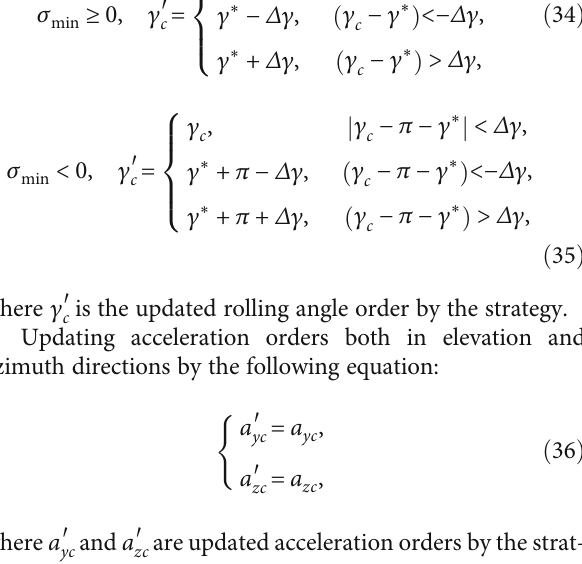
Table 1: Algorithm of the guidance strategy. Calculating heading error angle σ from equation